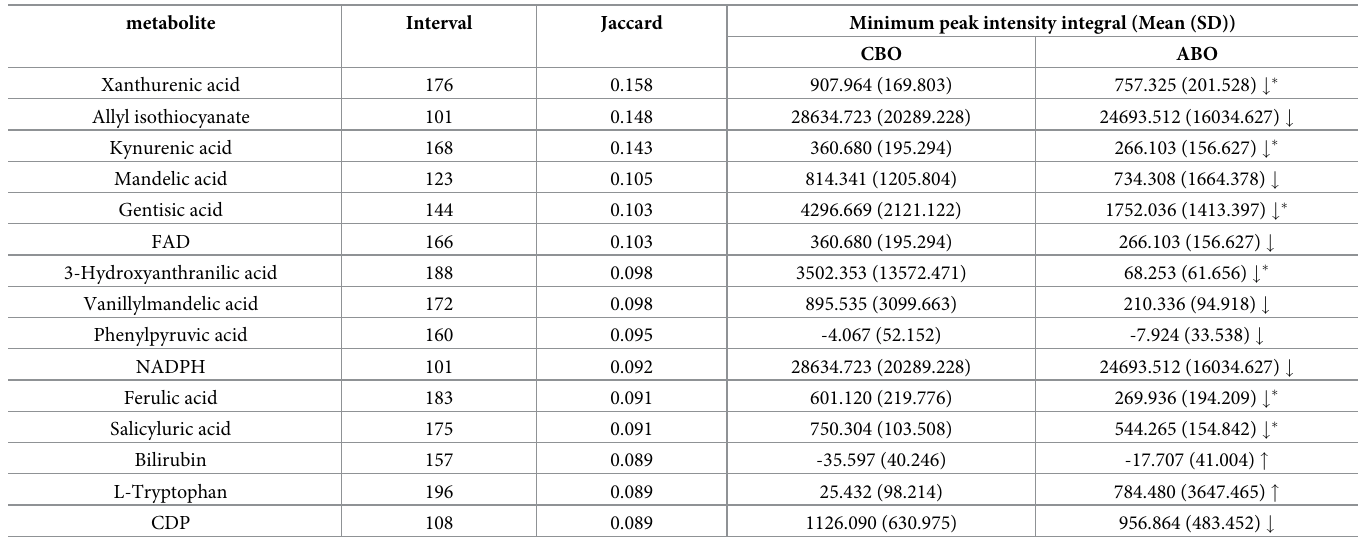
Table 2. Comparison of the lowest peak area of metabolites.